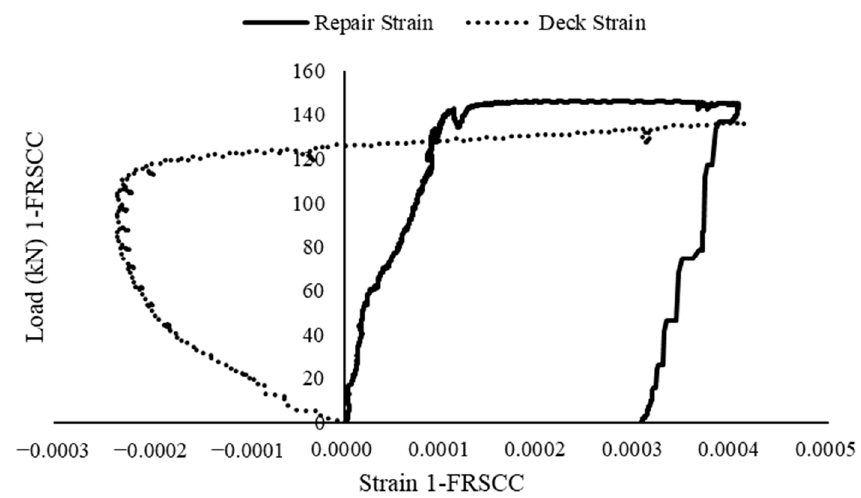
Figure 9. 1-FRSCC load vs. strain for each instrumented reinforcing bar.